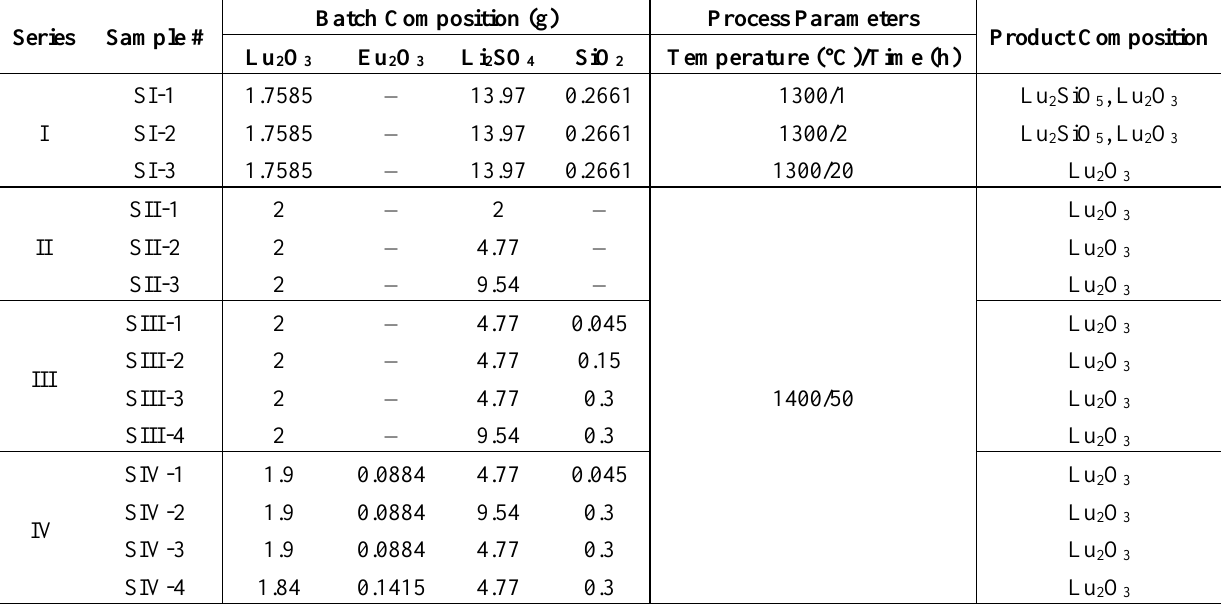
Table 4. Exemplary amounts of starting materials for the four series of synthesized